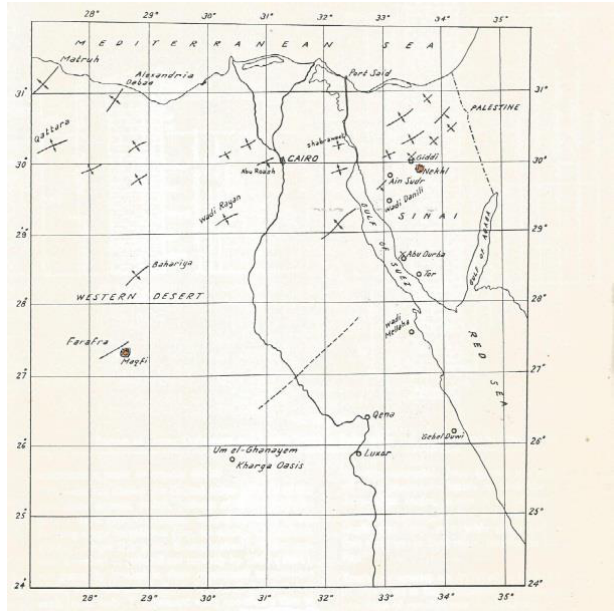
Figure 1: Map of Egypt showing location of section studied (Maqfi section and Nekhl section) in relation of the Syrian-swell structural trend (after Said & Kenawy,